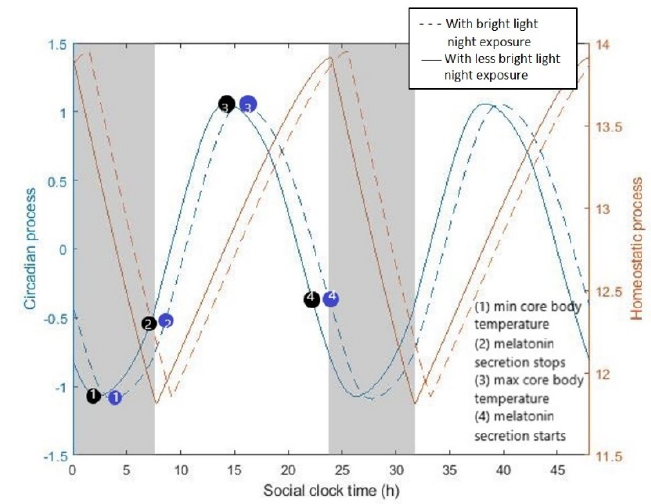
Figure 1. Schematic of the typical oscillation profile of the two processes that regulate sleep. The homeostatic sleep pressure H increases during wakefulness and declines during sleep, while the circadian process C describes the regulation of the body’s internal biological processes and alertness levels. The natural sleep-wake cycle (shaded region) is indicated by the interaction of homeostatic and circadian components, as described by Equation (10). The lighting profiles used as input to the model are presented in Figure 2a (far from window and bright light night exposure and far from window and no bright light night exposure, respectively).